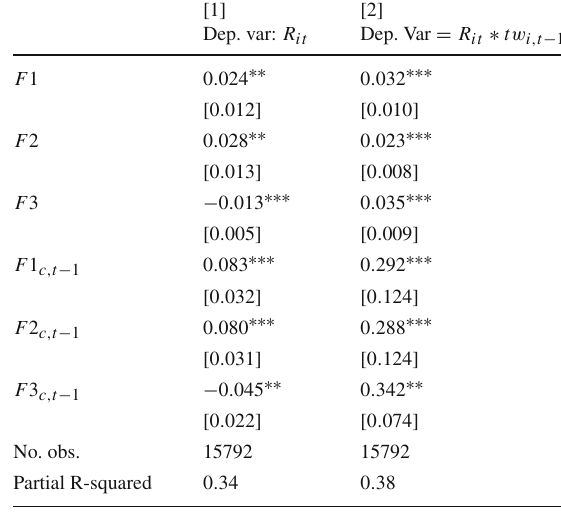
Table 6 First-stage estimates in GMM estimation